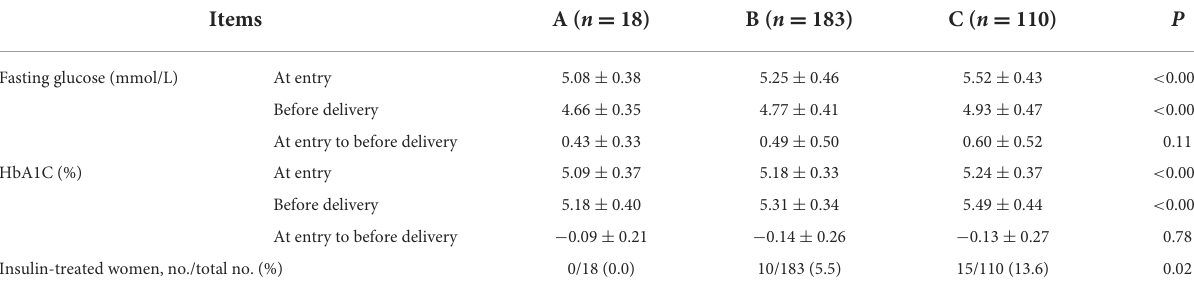
TABLE 2 Comparison of blood glucose changes among the three groups ( ¯ X ±